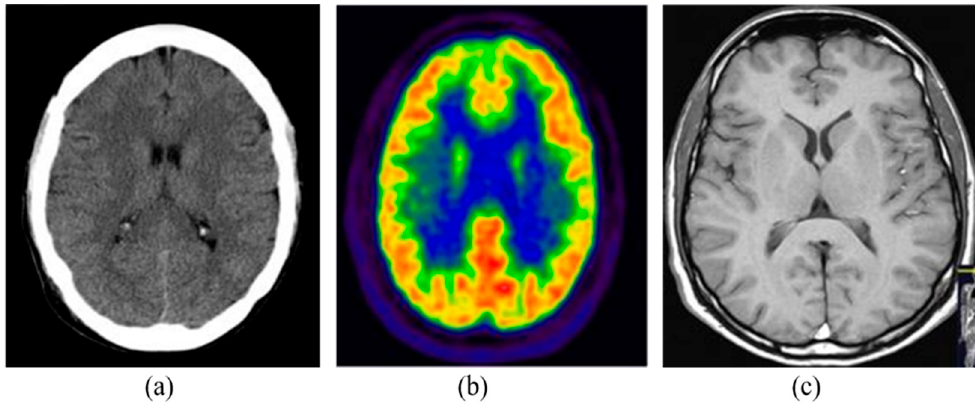
Figure 1. Brain imaging using different modalities: ( a ) CT, ( b ) PET, ( c ) MRI.